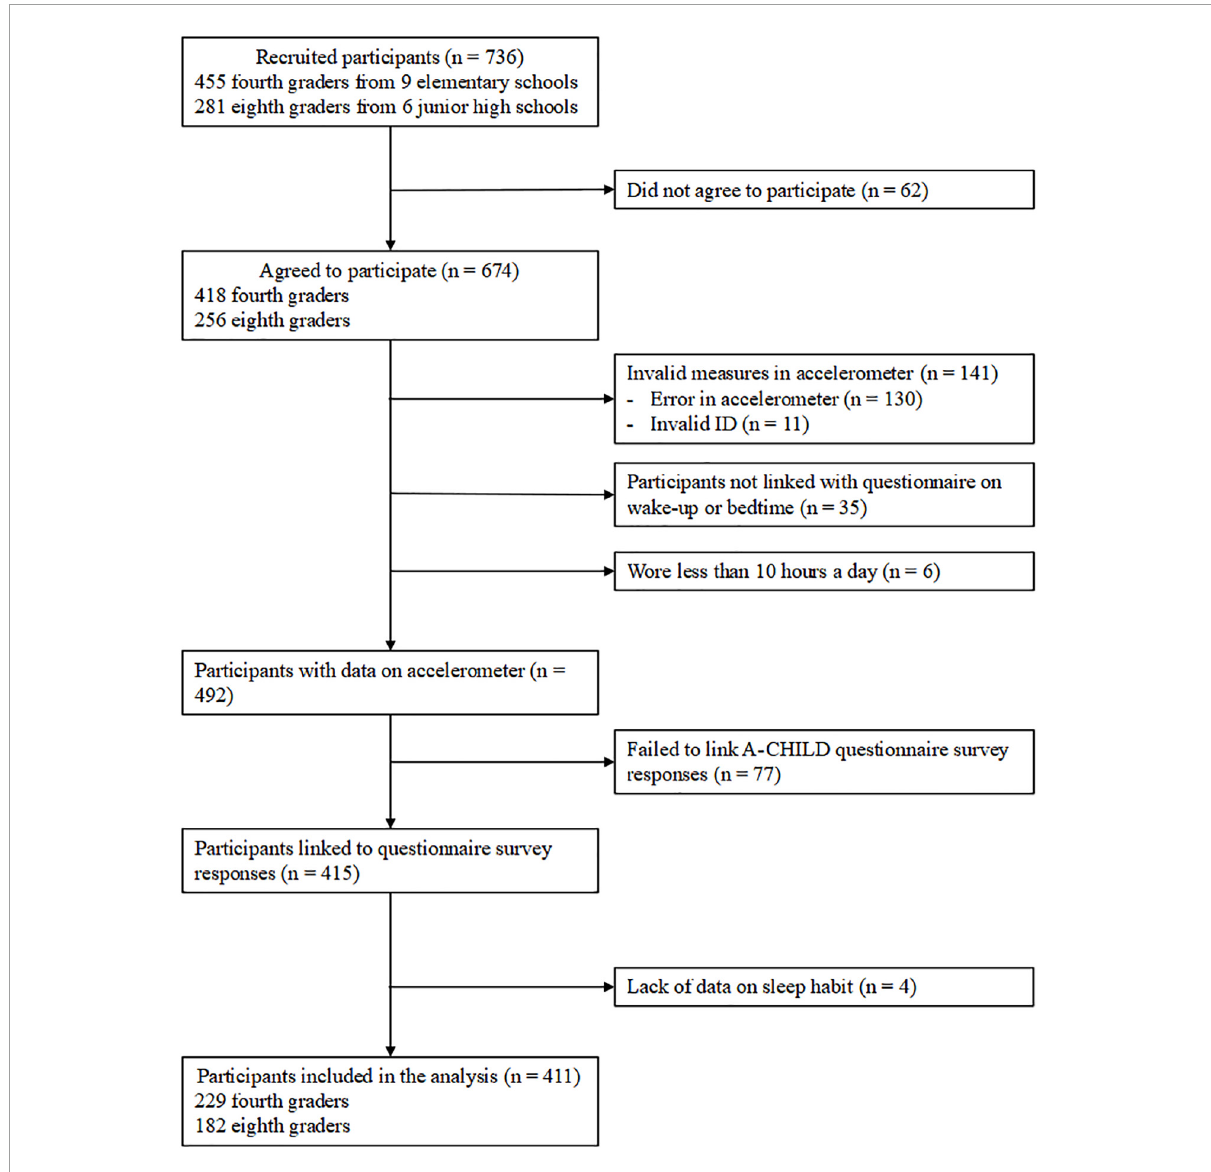
FIGURE1 Flow chart of study participants.